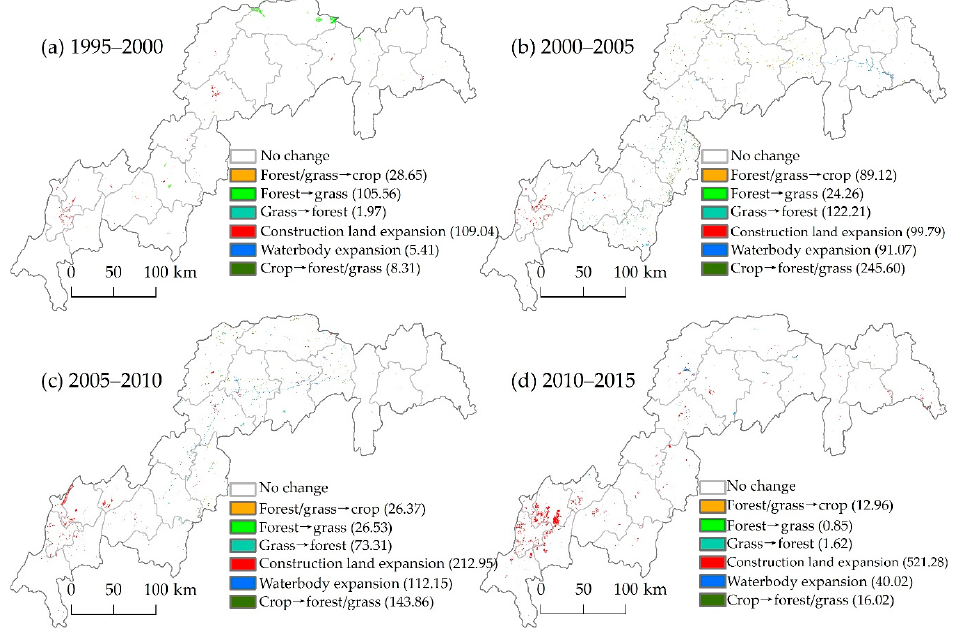
Figure 4. Land use transformation in the Three Gorges Reservoir Area for ( a ) 1995–2000, ( b ) 2000– 2005, ( c ) 2005–2010, and ( d ) 2010–2015. The numbers in parentheses indicate the total area (unit: km 2 )